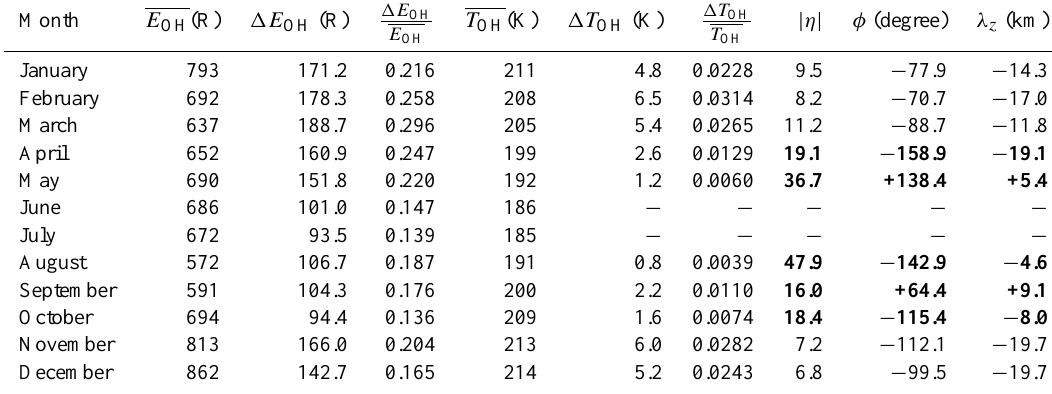
Table 2. Summary of wave parameters from OH layer. Solutions obtained from amplitudes smaller than 3K are listed in bold.